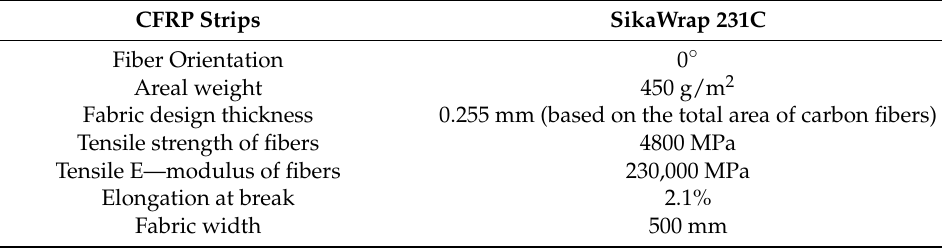
Table 2. Mechanical properties of CFRP strips (provided by Sika, Baghdad, Iraq).